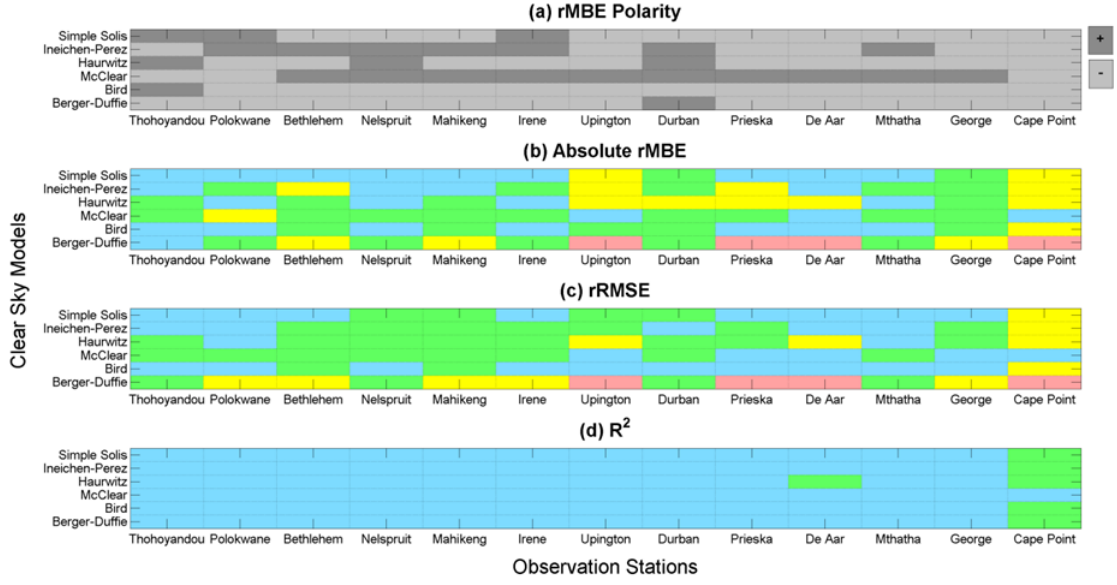
Figure 8. Comparison between observed and modelled minute GHI values in Cape Point ( a ), Nelspruit ( b ), Durban ( c ), and Mthatha ( d ).